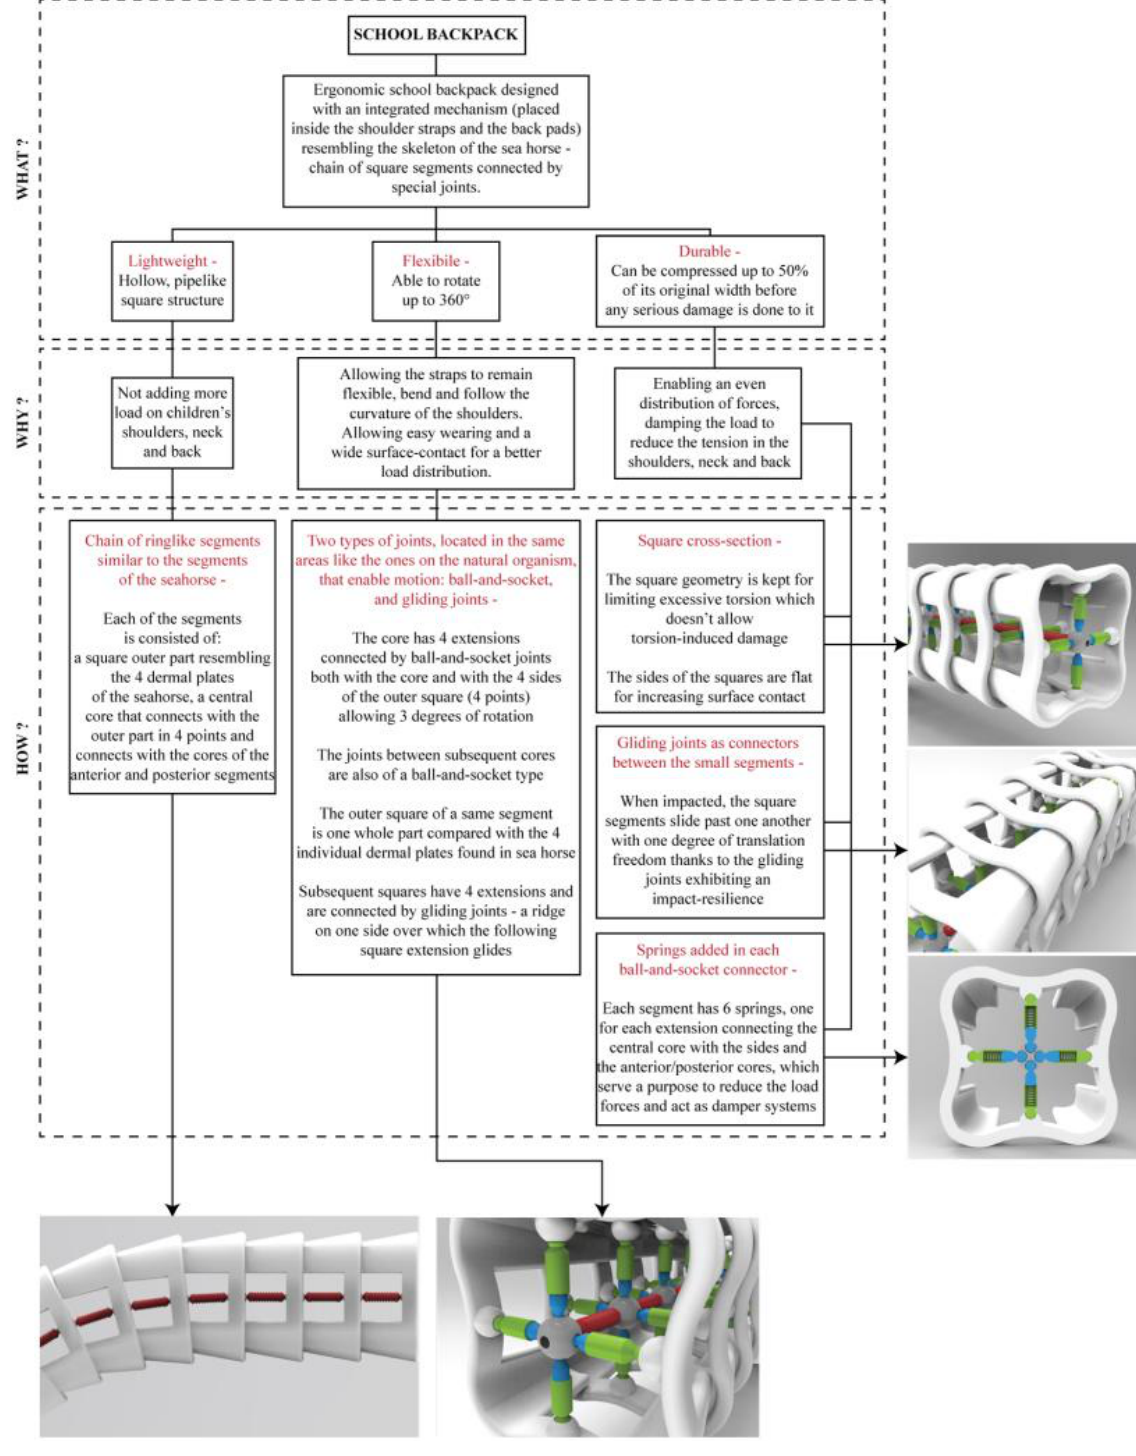
Figure 10. Functional analysis of the designed mechanism for school backpacks